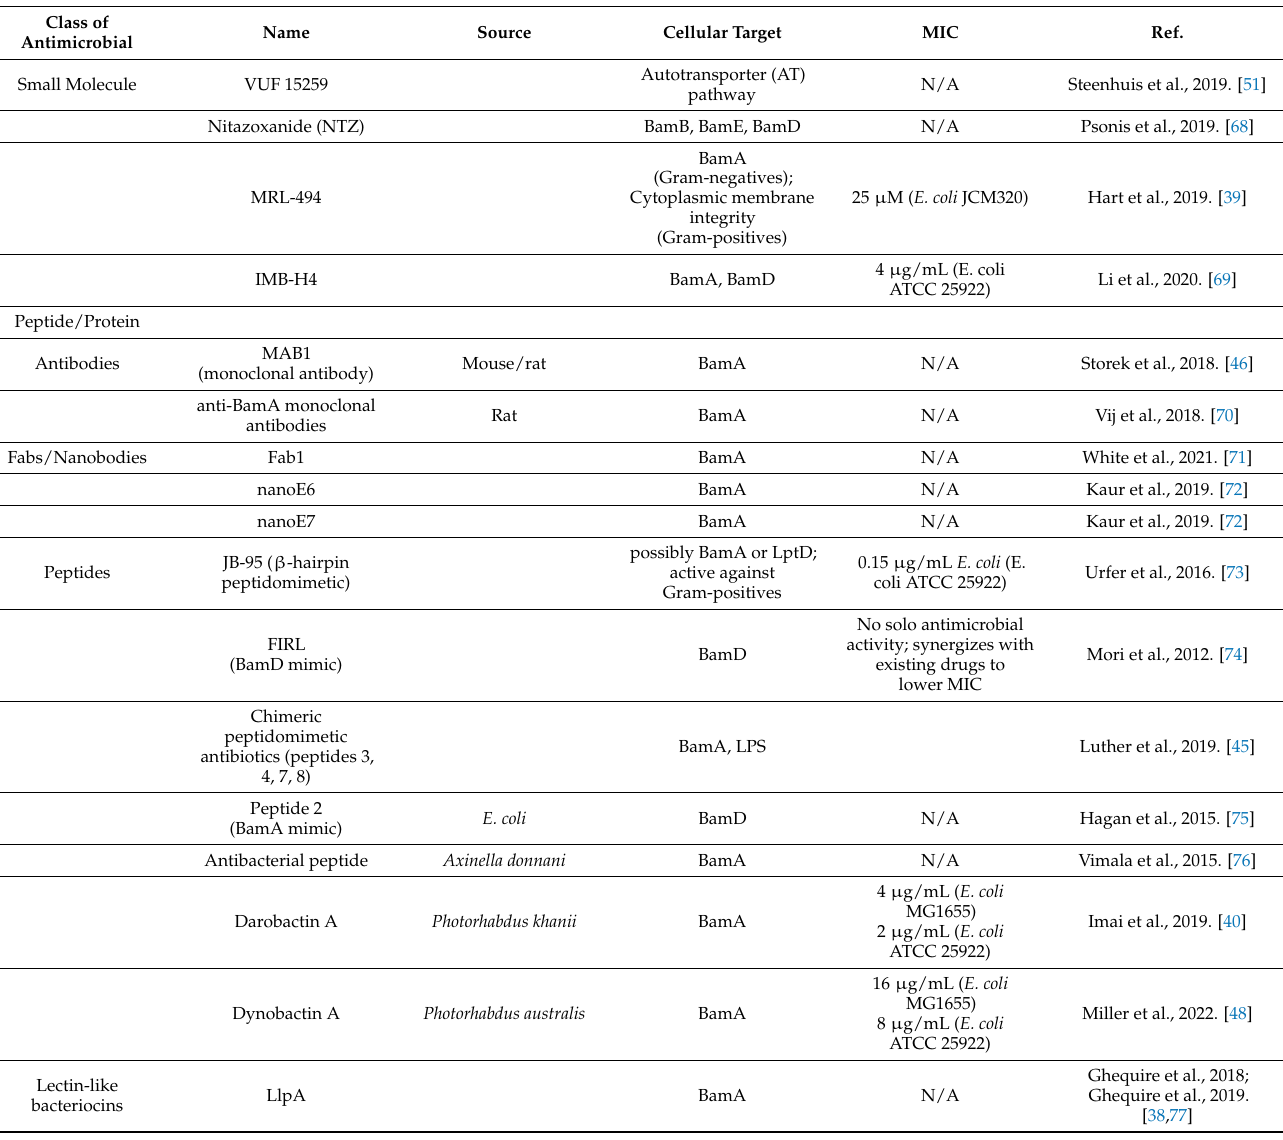
Table 2. Summary of small molecules and biologics targeting BAM. List of select small molecules, peptides or peptide mimics, antibodies, Fabs, and nanobodies that disrupt BAM function by targeting specific Bam